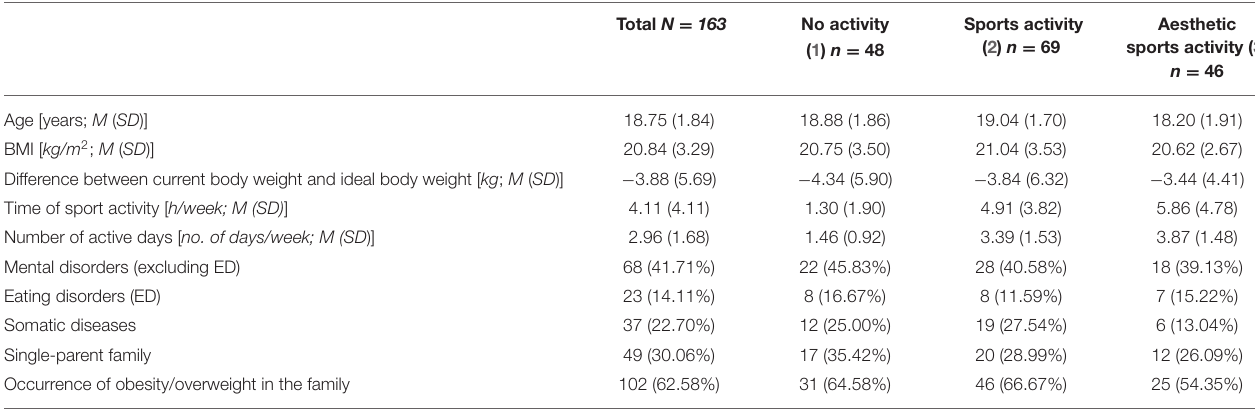
TABLE 1 | Characteristics of the sample.